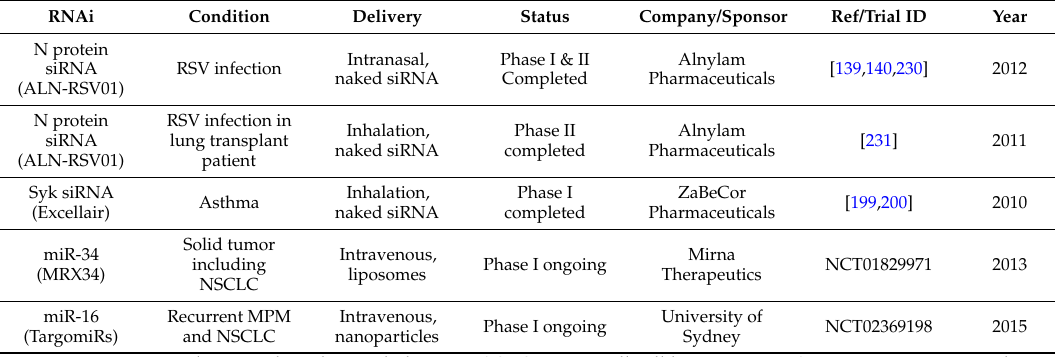
Table 6. Summary of clinical trials of RNAi therapeutics in respiratory